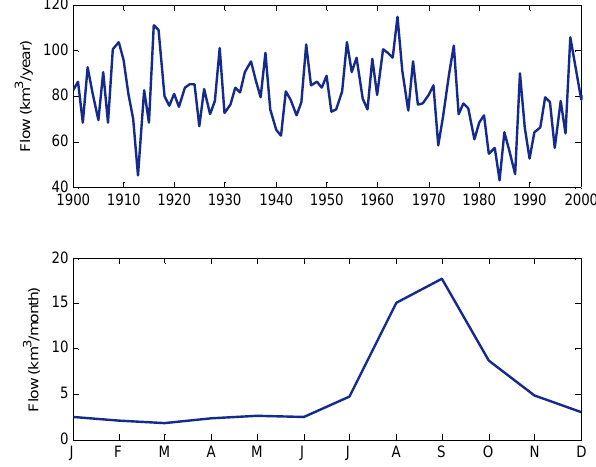
Figure 2. Annual Nile flow (top panel) and seasonal cycle (bottom panel) of the flow at Dongola for the period from 1900 to